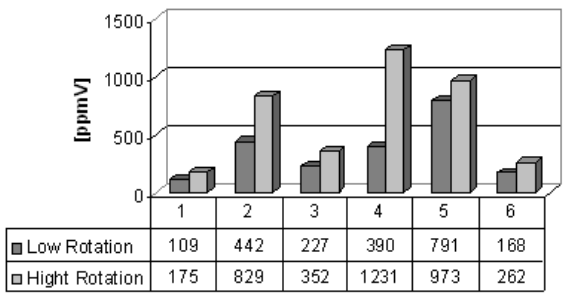
Figure 5. Carbon monoxide gas concentration